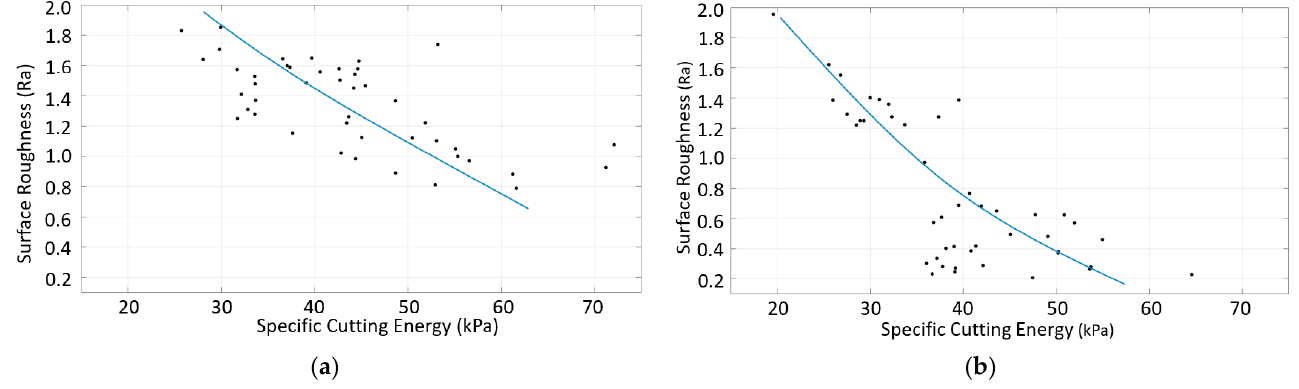
Figure 20. Surface roughness vs. specific cutting energy for the down-milling of multi-material components with ( a ) SS machined and ( b ) CRS machined.